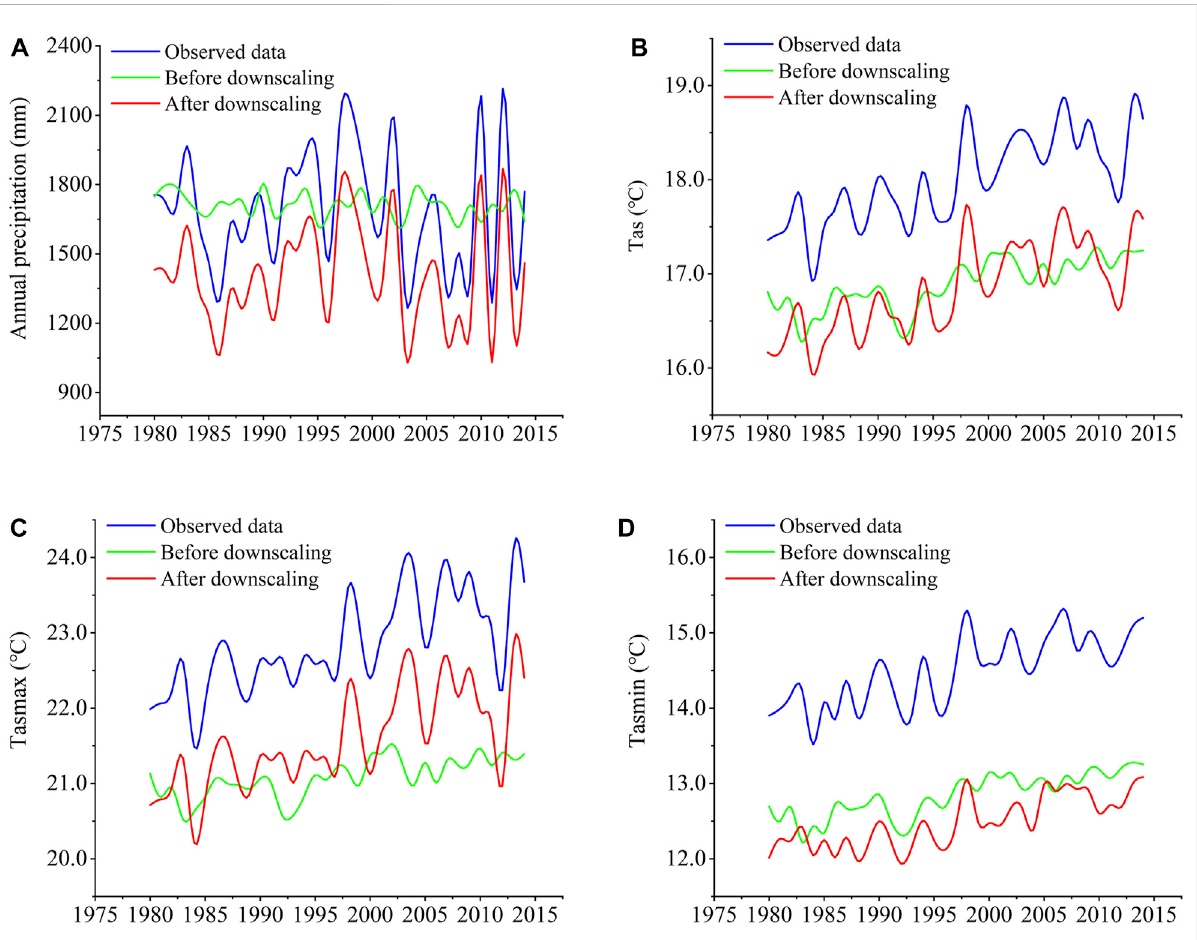
FIGURE 3 CMIP6 multi-model ensemble precipitation and temperature time series simulation of observation data. (A – D) are the precipitation, Tas, Tasmax and Tasmin of the